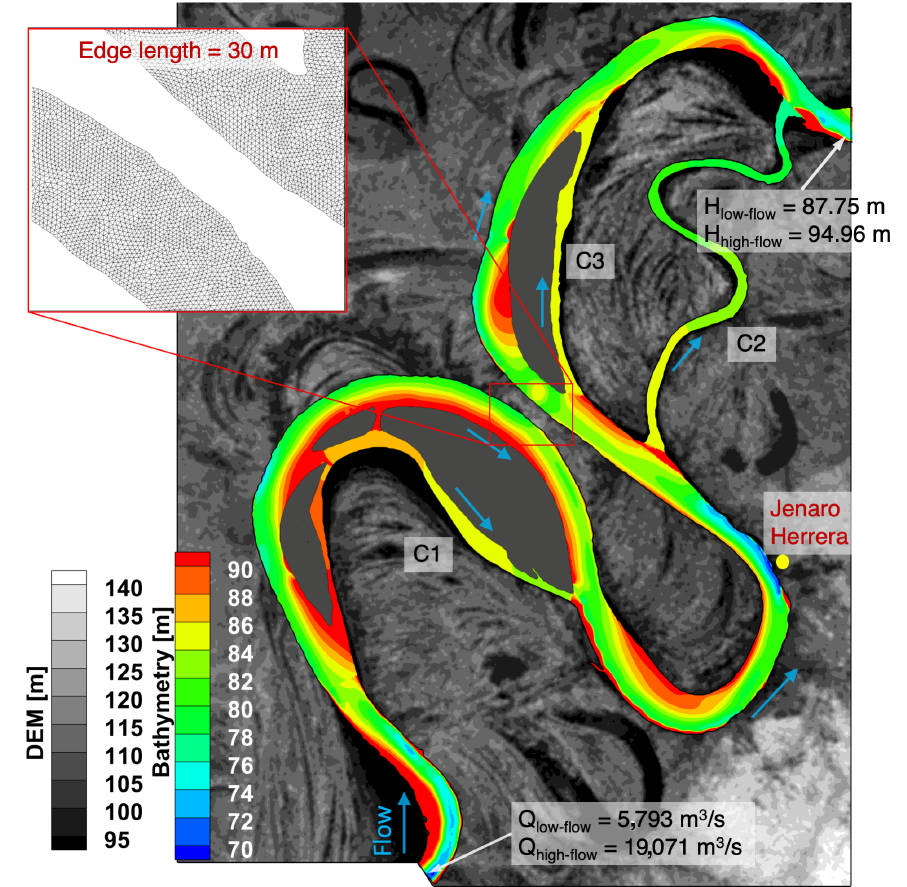
Figure 6. Bed elevation of the JH bend (May 2013). Q high − flow = 19,071 m 3 /s and Q low − flow = 5793 m 3 /s represent water discharges for May and August 2013, respectively. H high − flow = 94.96 m and H low − flow = 87.75 m represent water surface elevation for May and August 2013, respectively. Secondary channels C1, C2 and C3 are elevated